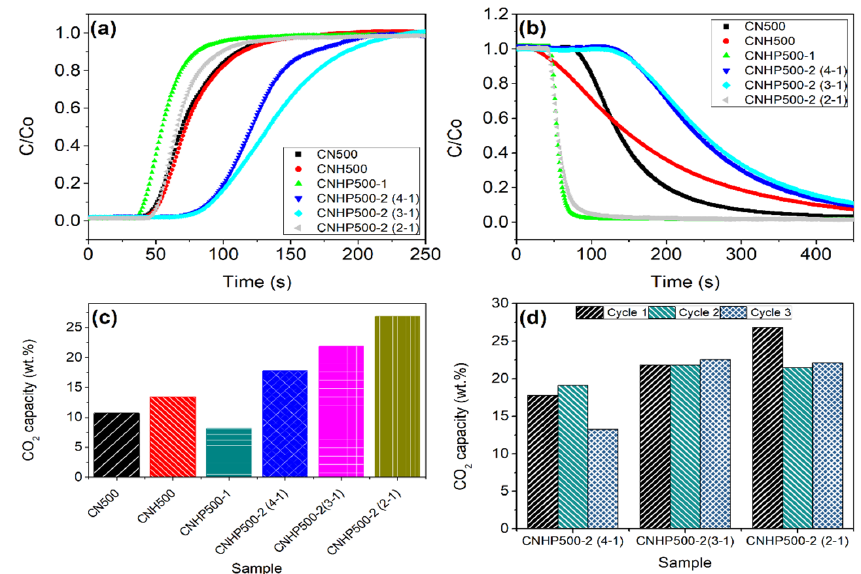
Figure 6. ( a ) Adsorption and ( b ) desorption isotherm of sample CN500, CNH500, CNHP500-1, CNHP500-2(4-1), CNHP500-2(3-1), and CNHP500-2(2-1). ( c ) CO 2 capture capacity of different samples at 50 ml/min and room condition (1 atm, 25 ◦ C). ( d ) CO 2 capture capacity of sample CNHP500-2(4-1), CNHP500-2(3-1), and CNHP500-2(2-1) for 3 continuous